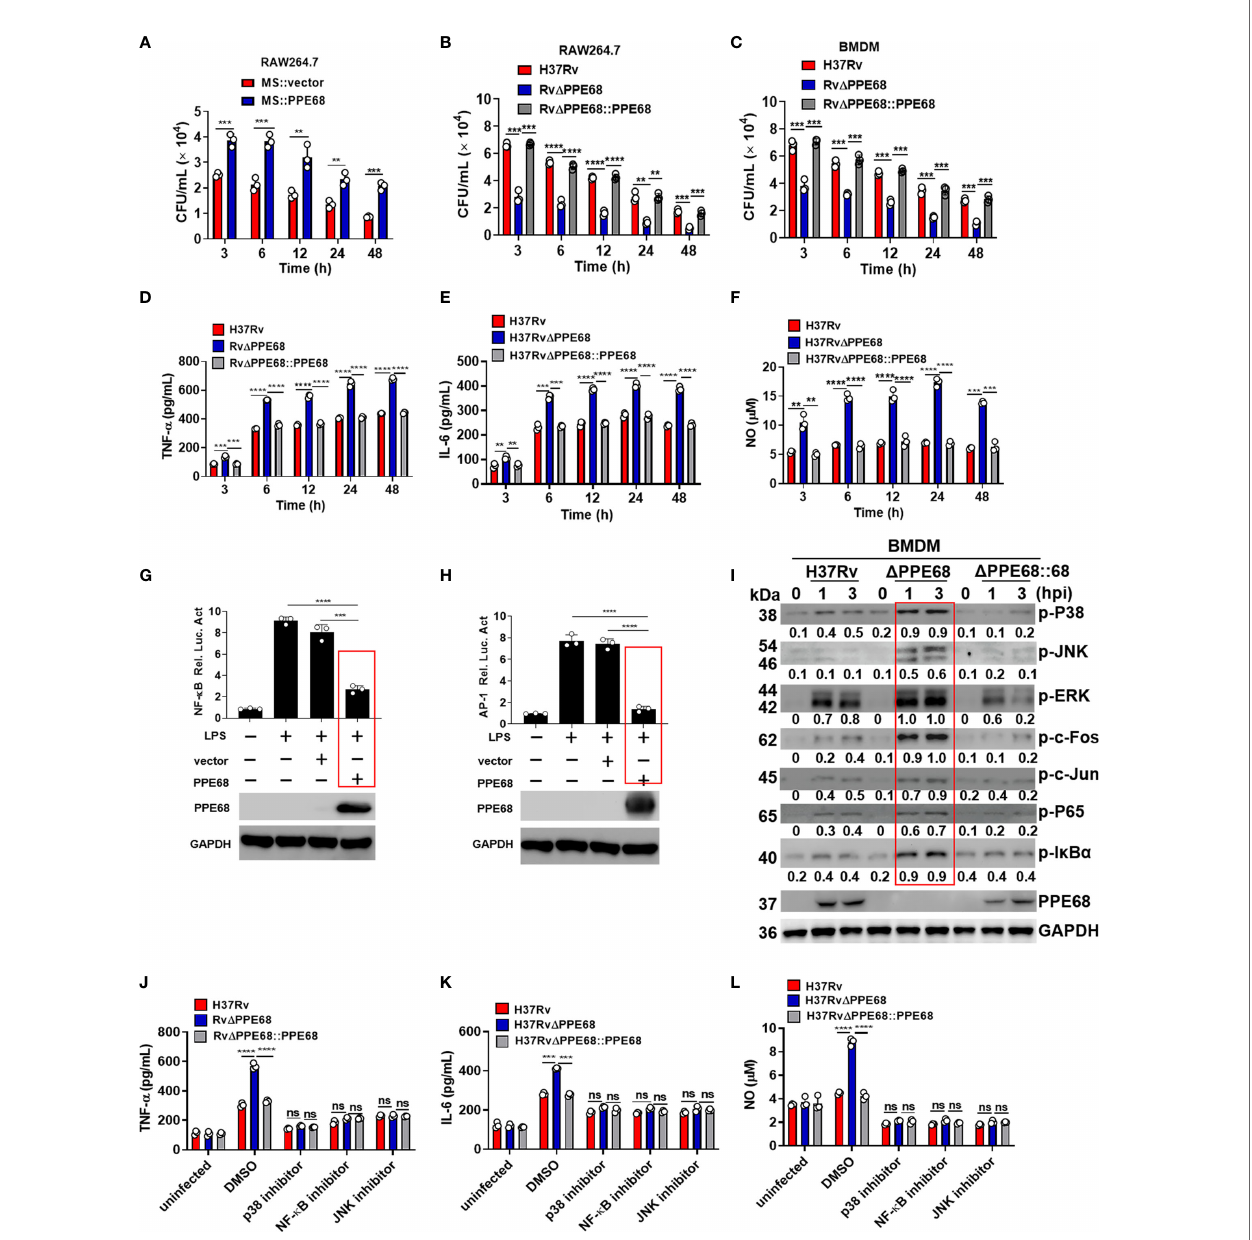
FIGURE 1 | PPE68 promotes mycobacterial survival and suppresses the production of TNF- a , IL-6 and NO in macrophages. (A-C) RAW264.7 (A, B) or BMDMs (C) were infected with MS::vector and MS::PPE68 (A) or H37Rv, Rv D PPE68 and Rv D PPE68::PPE68 (B, C) at a MOI of 10. The cells were harvested and lysed, and the burdens of intracellular bacteria were determined by CFU assay at various time points. (D-F) BMDMs were infected with H37Rv, Rv D PPE68 or Rv D PPE68:: PPE68. Secreted TNF- a (D) and IL-6 (E) protein levels were determined at each indicated time point by ELISA. NO (F) production was detected with the Griess assay. (G, H) Dual luciferase assay of the effect of PPE68 on NF- k B (G) or AP-1 (H) activation in RAW264.7 cells. (I) Western blot analysis of phosphorylated c-Fos, c-Jun, p65, I k B a , p38 JNK, and ERK and total GAPDH (loading control throughout) expression in BMDMs infected with H37Rv, Rv D PPE68 or Rv D PPE68::PPE68 for the indicated time. Relative densitometry quanti fi cation was analyzed based on GAPDH by ImageJ. (J-L) BMDMs were pretreated with DMSO, SP600125 (JNK inhibitor, 20 MM), SB203580 (p38 inhibitor, 30 MM), or BAY11-7082 (NF- k B inhibitor, 20 MM) for 1 h followed by infection with different strains (MOI = 10) for 6 h, and then the cells were lysed, and the supernatants were analyzed for TNF- a (J) , IL-6 (K) and NO (L) secretion. Data are expressed as the mean ± SD of three independent experiments for A-H, J-L, and two tailed unpaired t test was used to calculate statistical signi fi cance. p > 0.05, not signi fi cant (ns); ** p < 0.01; *** p < 0.005; **** p <